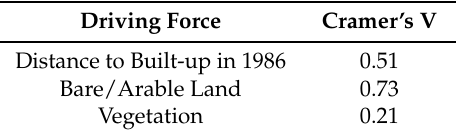
Table 13. Cramer’s V driving force threshold for potential LULCC to built-up.